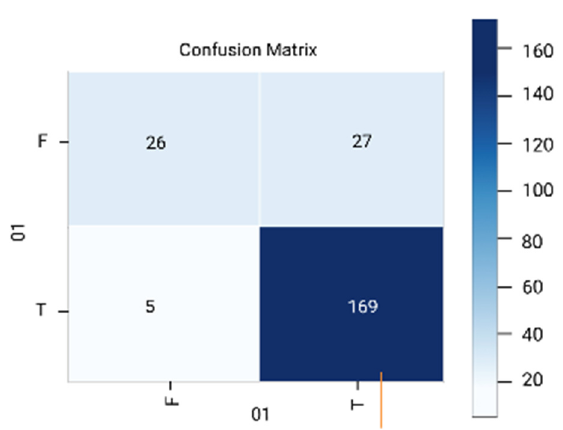
Figure 5. Logistic regression.